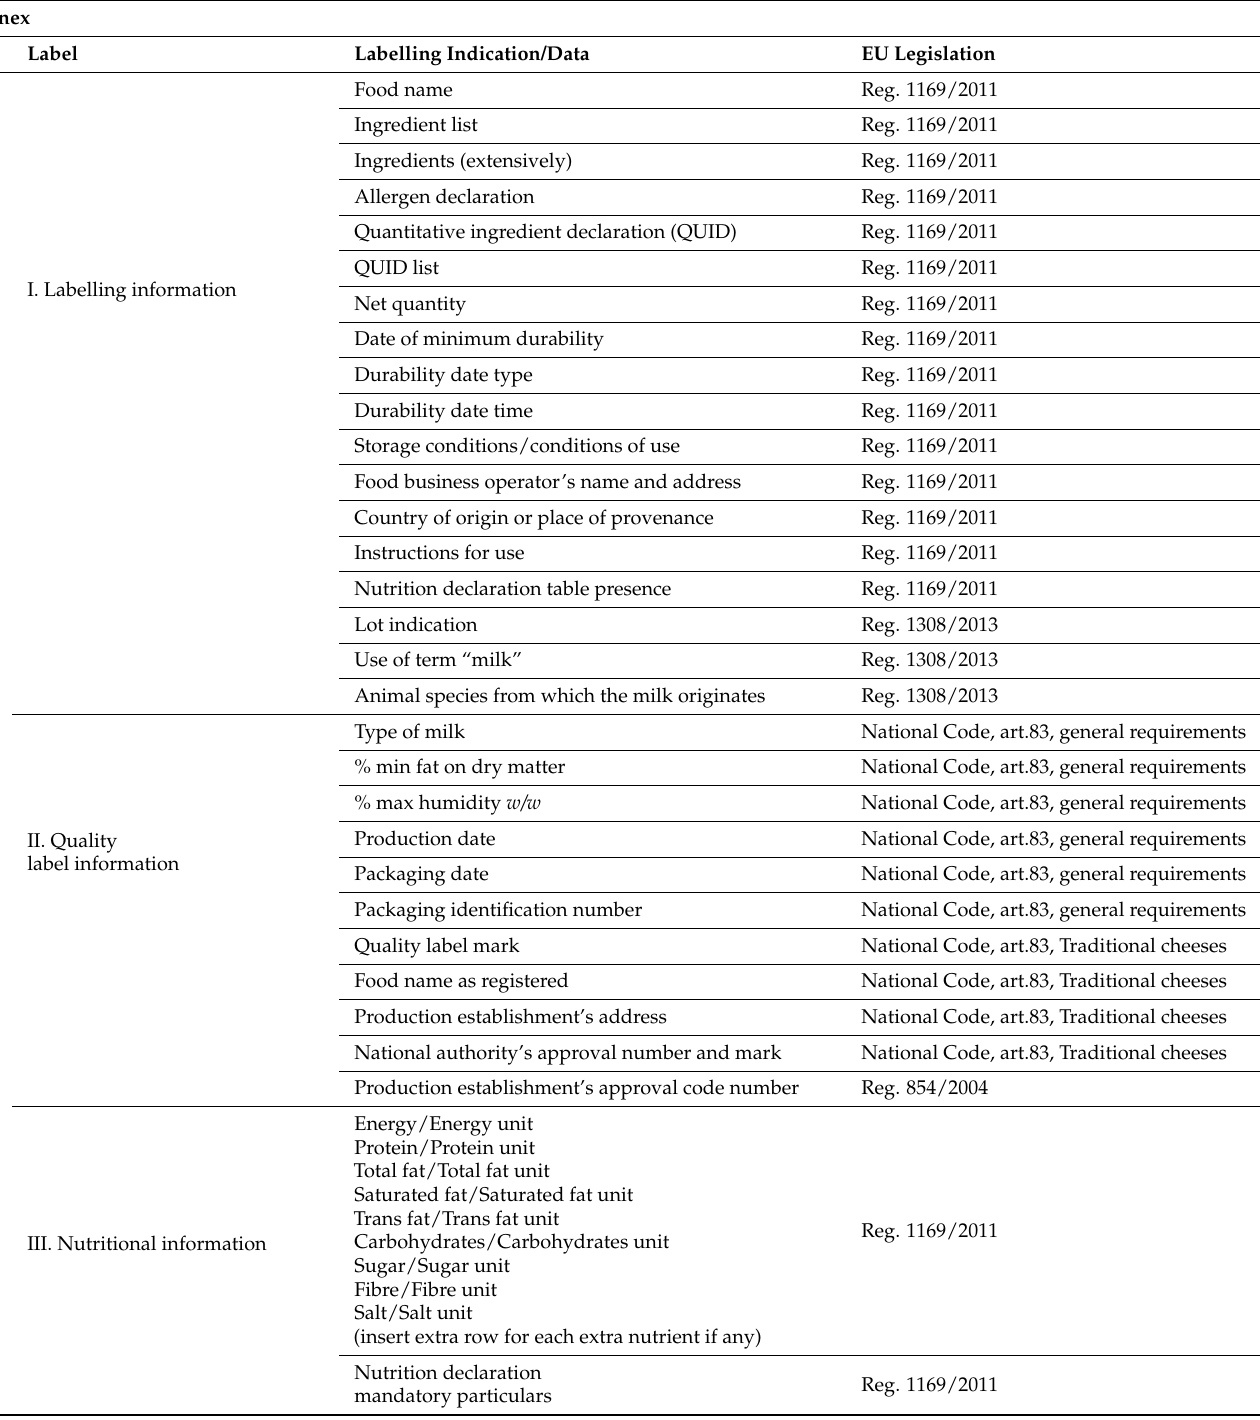
Table 1. Annex of labelling indications–data categories’ structure, used for label data collection accompanied with relative EU